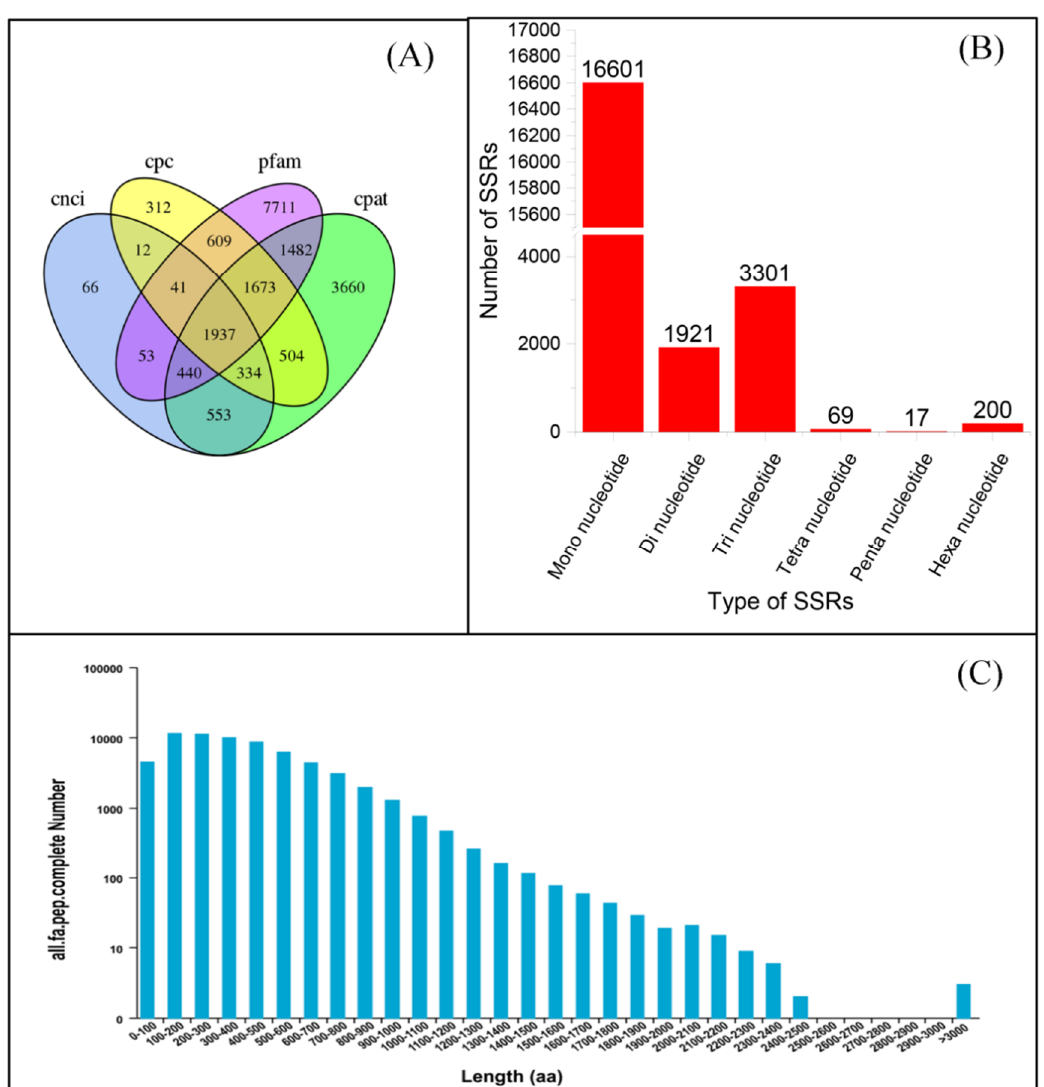
Figure 3. The identification of long non-coding RNAs (lncRNAs), simple sequence repeats (SSRs), and coding sequences (CDSs) of the Pinus elliottii transcriptome. ( A ) A Venn diagram of the number of lncRNAs predicted using the Coding Potential Calculator (CPC), coding-non-coding index (CNCI), coding potential assessment tool (CPAT), and hmmscan algorithm against Pfam database. ( B ) The histogram representing the number of different types of SSRs. ( C ) The distribution of the protein length of predicted CDSs. The xlab represents the length range of the proteins, and the ylab stands for the number within each range.